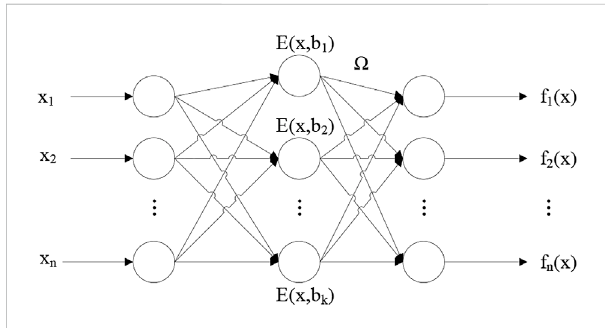
FIGURE 2 Topological structure diagram of RBF neural